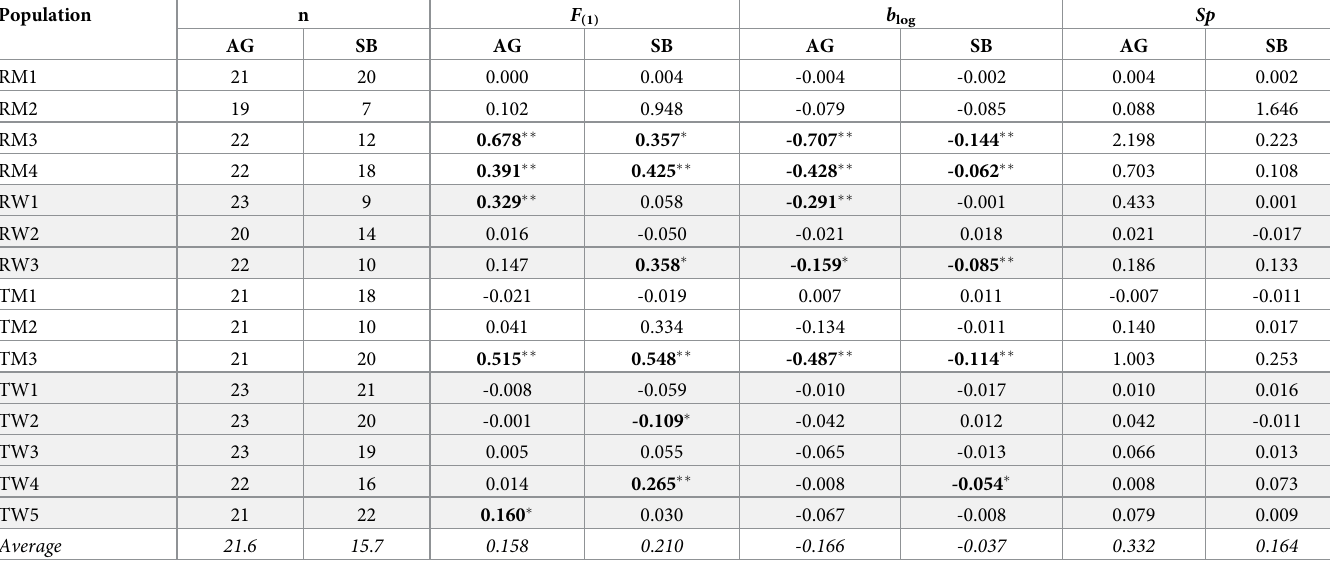
Table 4. Small-scale genetic structure for aboveground and seed bank individuals in populations of Viola elatior .